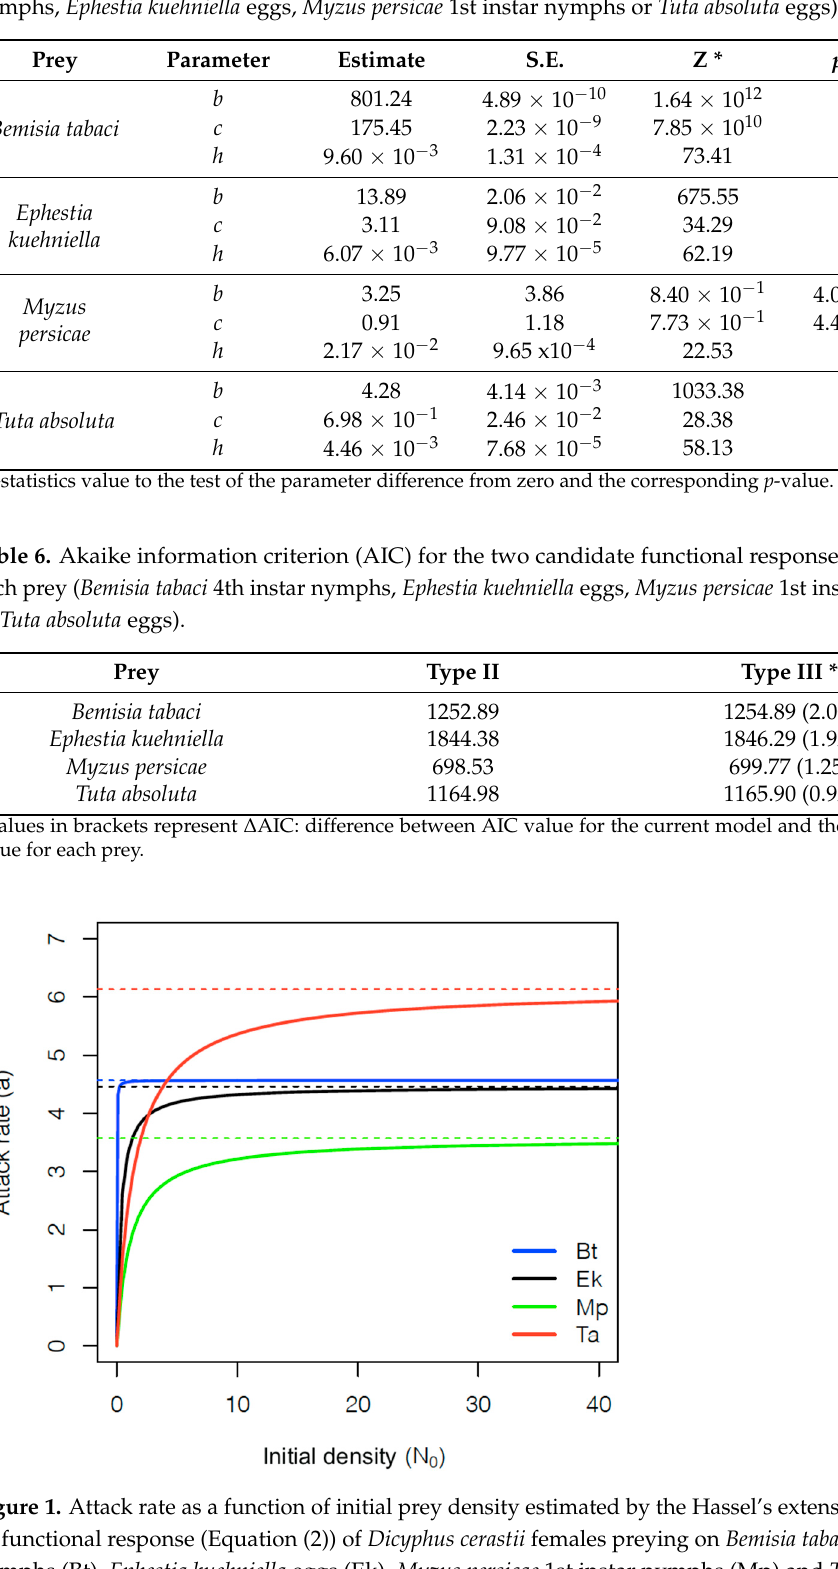
Table 5. Parameters b and c, and h (handling time), and respective standard error (S.E.) estimated by maximum likelihood using Hassel’s extension to Rogers’s random predator equation (Type III functional response) for Dicyphus cerastii females feeding on different prey ( Bemisia tabaci 4th instar